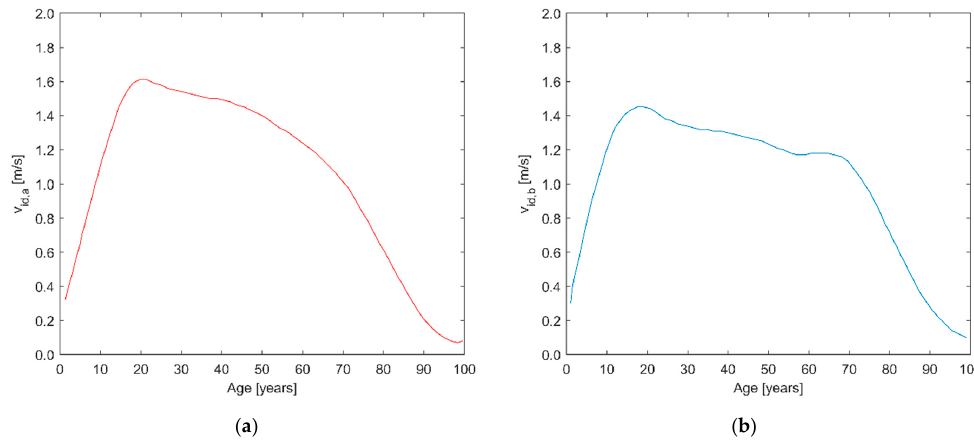
Figure 1. Reference curves for speed normalization depending on the individuals’ age according to: ( a ) the curve a , to derive v id,a [46] and ( b ) to the curve b , to derive v id,b [43].